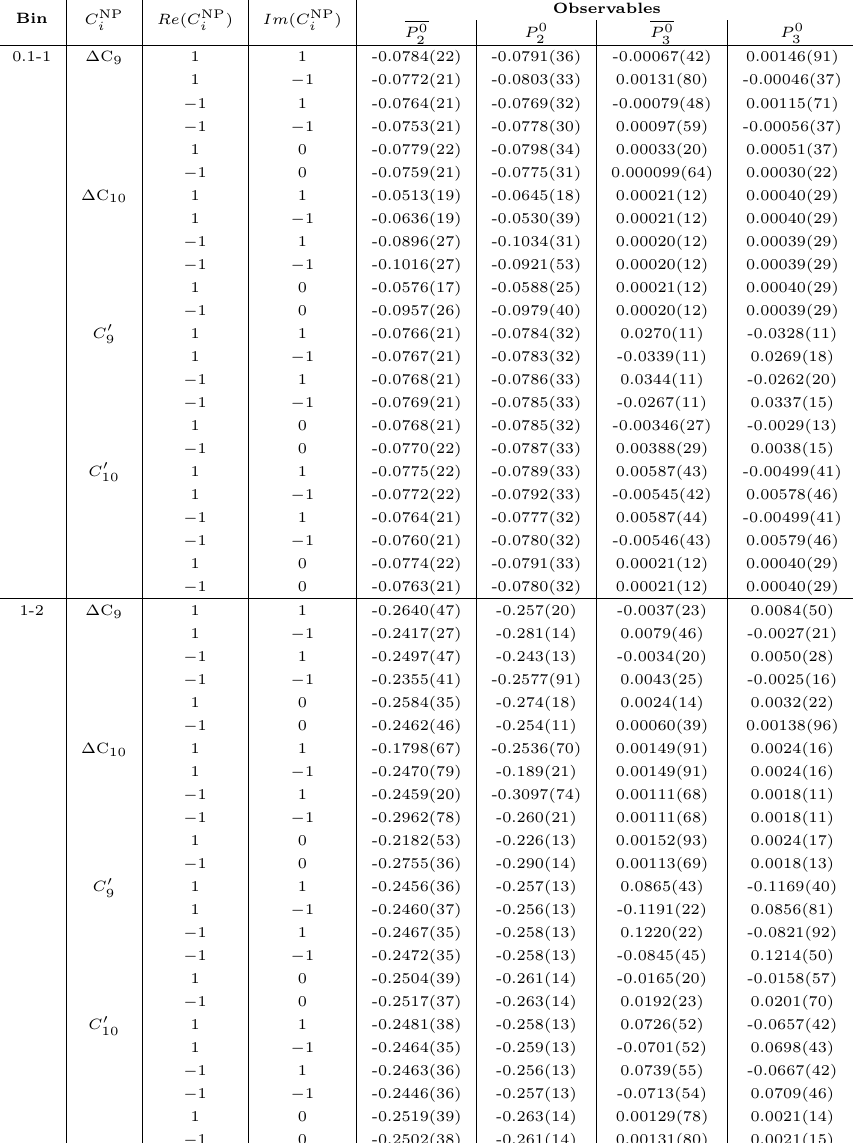
¯ B 0 → ρ 0 ll and C 0 for the q 2 9 , 10 9 , 10